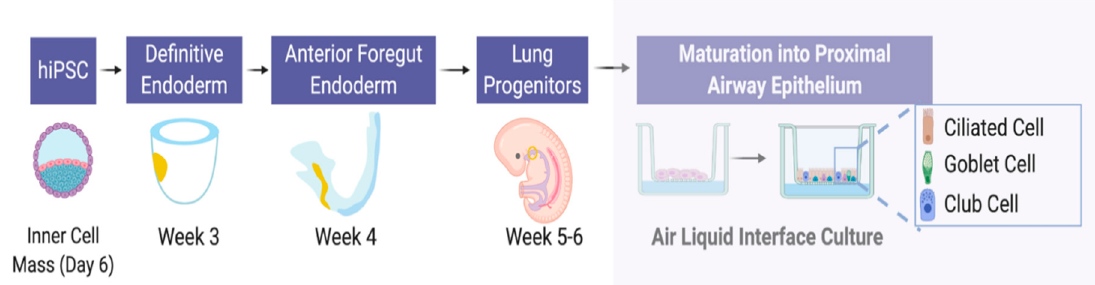
Figure 3. Derivation of proximal airway epithelial cells from induced pluripotent stem (iPS) cells. Schematic representation of the embryologically guided stepwise approach to generate mature proximal epithelial cells. The first requirement is the generation of definitive endoderm (equivalent to cells at approximately 3 weeks post conception) from iPS cells (equivalent to the cells found in the inner cell mass of the blastocyst at day 6). The second stage is di ff erentiation to anterior foregut endoderm (equivalent to cells at approximately 4 weeks post conception). Cells are then di ff erentiated via ventralization